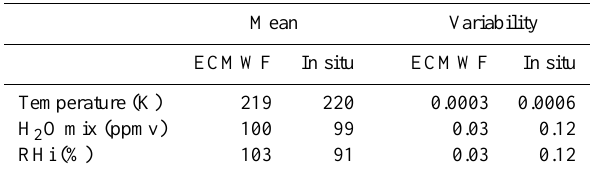
Table 3. Mean values and relative variability (averaged between 11:25 and 11:54UTC) along Falcon flight path on 4 Novem- ber 2010. For the ECMWF relative humidity uncorrected model temperature data are used. In situ relative humidity is determined from WARAN water vapour measurements and in situ temperature measurements onboard the Falcon. Mean Variability ECMWF In situ ECMWF In situ Temperature (K)